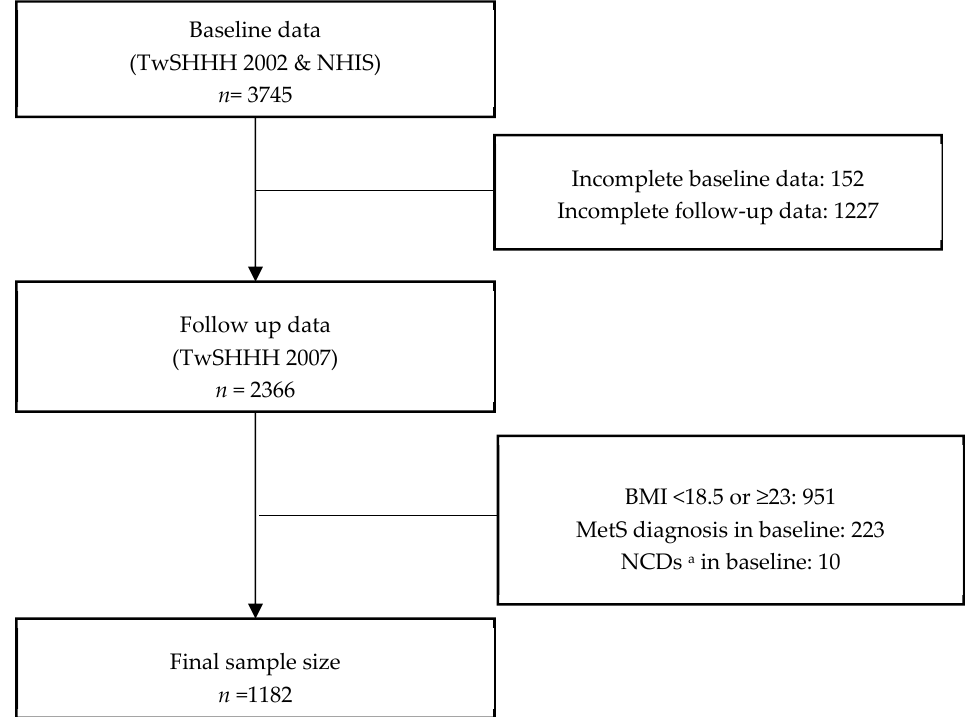
Figure 1. Sample selection process from 2001 National Health Interview Survey (NHIS) and 2002 and 2007 Taiwan Survey on the Prevalence of Hypertension, Hyperglycemia, and Hyperlipidemia (TwSHHH) respondents. Abbreviations: n , number of respondents; MetS, metabolic syndrome. a Selected noncommunicable disease (i.e., hypertension, dyslipidemia, and type 2 diabetes mellitus (T2DM)).